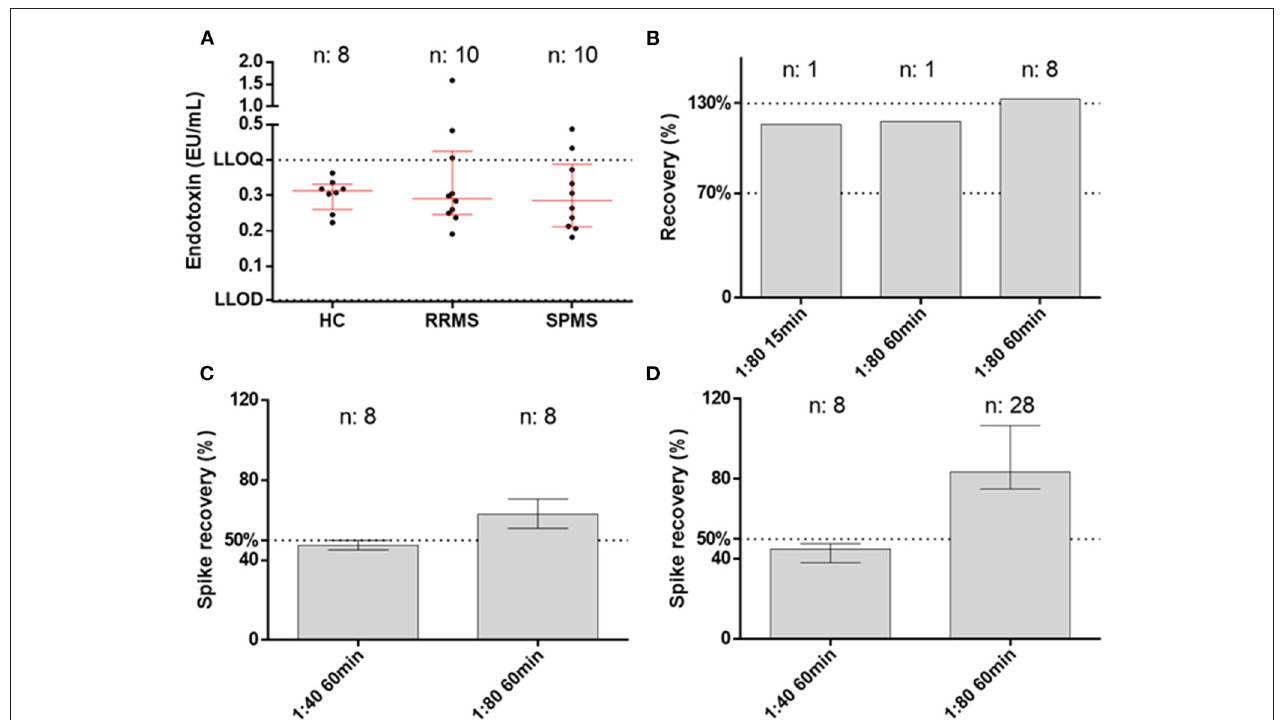
FIGURE 5 | Endotoxin levels in samples and assay performance. (A) Endotoxin levels in healthy controls (HC), relapsing–remitting multiple sclerosis patients (RRMS), and secondary progressive multiple sclerosis patients (SPMS) measured at the best conditions of 1:80 dilution and 60min of heat treatment. (B) Parallelism for the native sample with both 15 and 60min of heat treatment. The third column shows the dilution linearity on spiked samples that remained at the upper level of the accepted range (70–130%). (C,D) Spike recovery pre- and post-dilution.